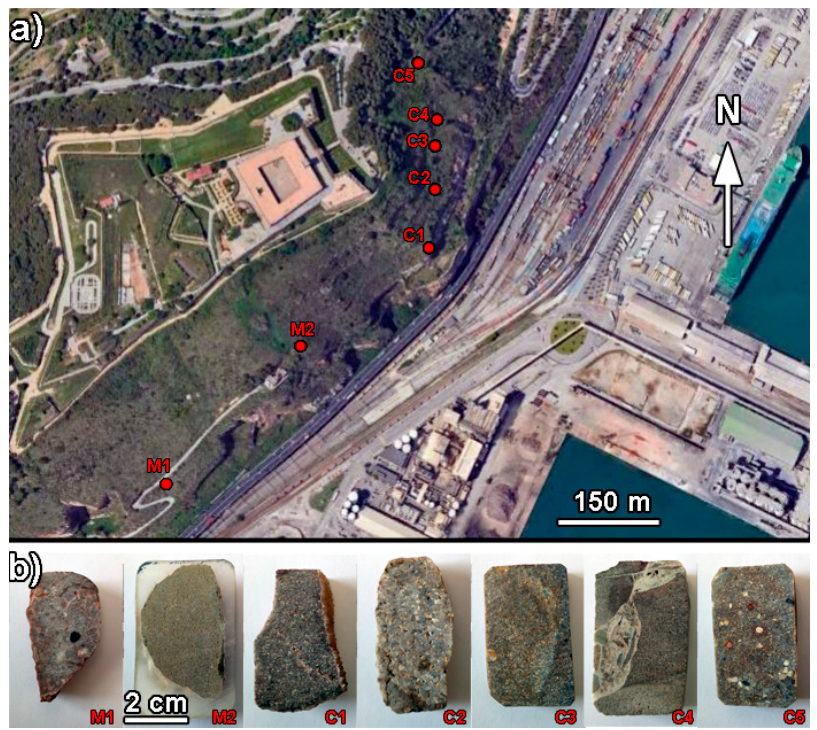
Figure 5. ( a ) Satellite image where some representative sampling sites (red dots) along the Monjtuïc cliff have been highlighted; ( b ) the corresponding samples, belonging to Morrot (M1 and M2) and Castell (C1 to C5) units. To note: M2 corresponds to a calcite nodule from the upper Morrot unit; silificated late fractures are clearly seen in C4 sample and sample C1 (right side).